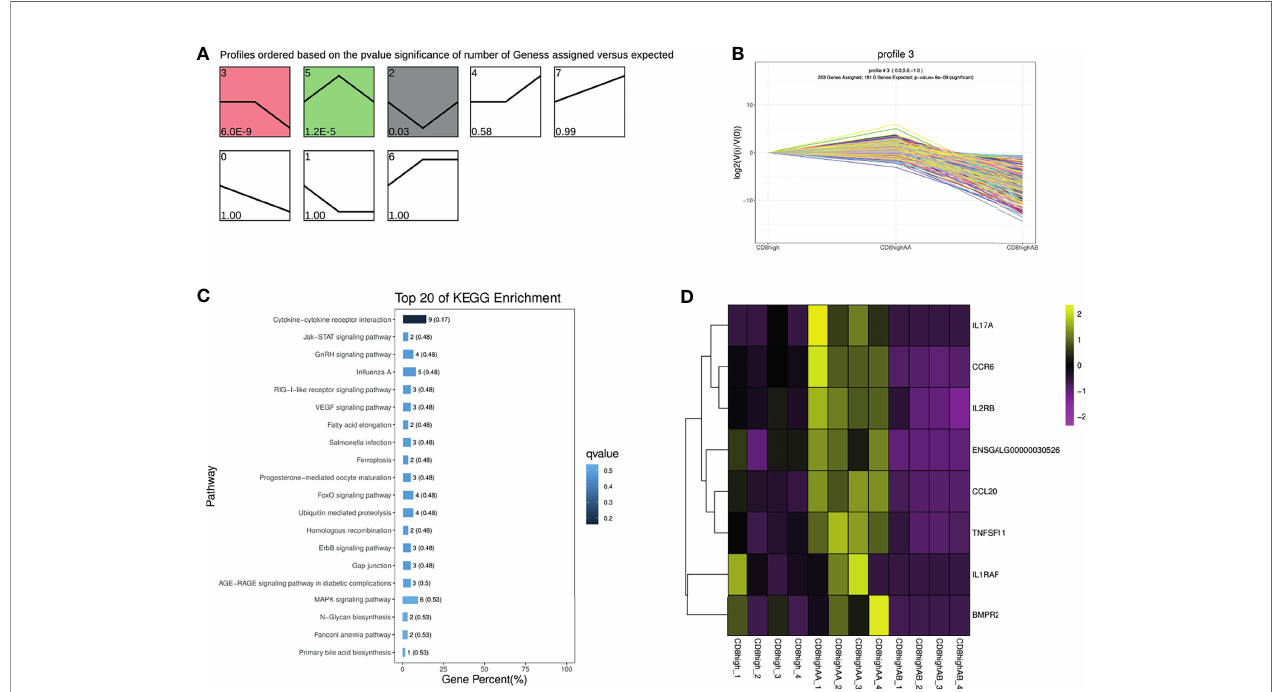
FIGURE 2 | Trend analysis of CD8 high+ , CD8 high aa + , and CD8 high ab + T cells. (A) All differentially expressed gene (DEG) expression pro fi les ordered based on the p values in the order of CD8 high+ T cells (containing CD8 high aa + and CD8 high ab + T cells), CD8 high aa + T cells and CD8 high ab + T cells. (B) The DEG expression trends in pro fi le 3. (C) Top 20 KEGG pathways were selected for pro fi le 3 DEGs enrichment. (D) Heat map of DEGs expression enriched in the “ Cytokine – cytokine receptor interaction ” pathway.